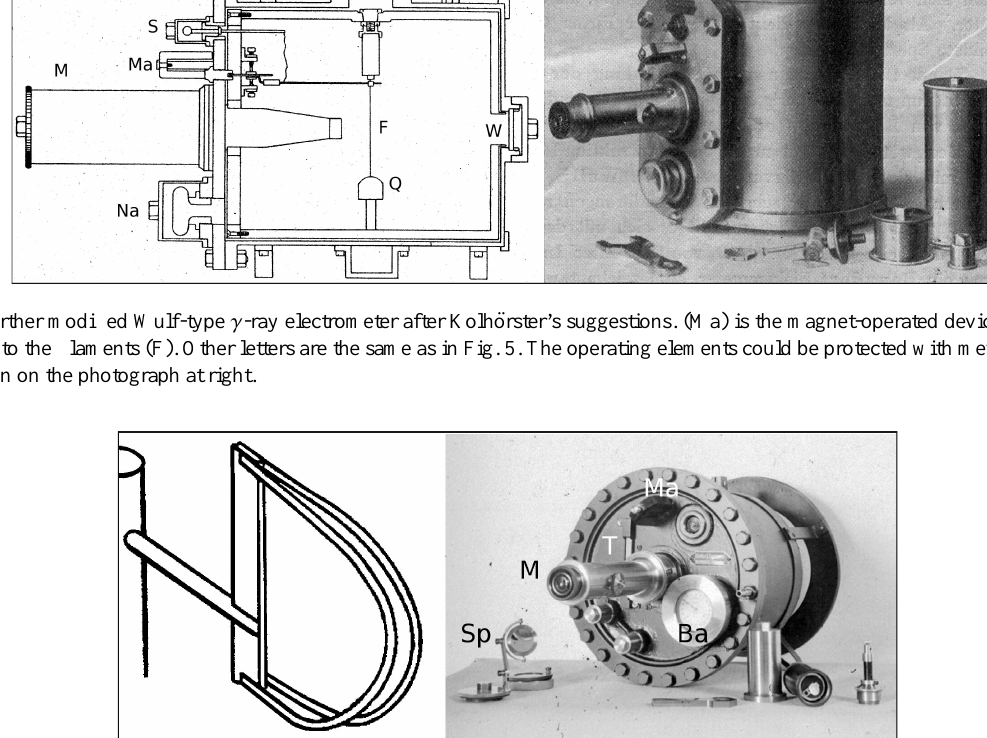
and nuclear reactor measuring techniques (which no longer exists) – Otto Tegetmeyer died on 21 August